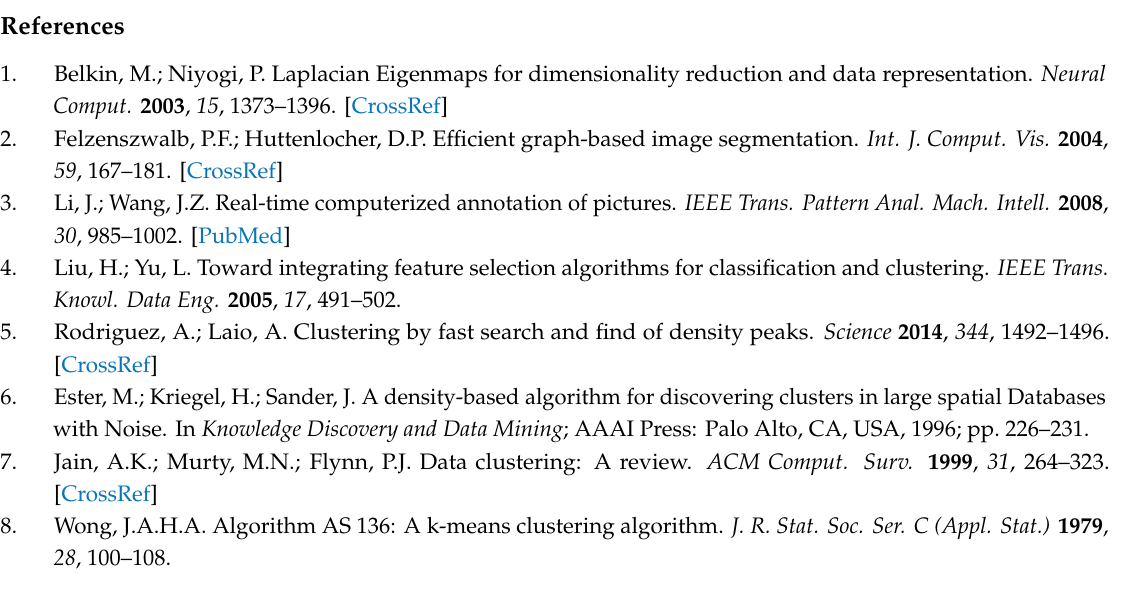
Figure 12. Mean OSPA and computing time of 100 steps × 100 MC runs, with different numbers of sensors.